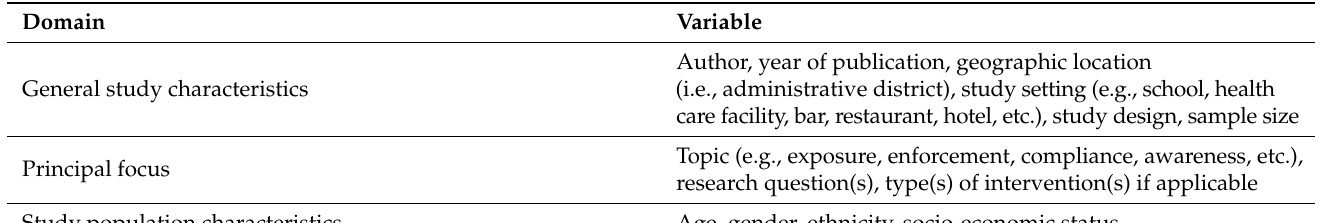
Table 1. Data extraction domains and